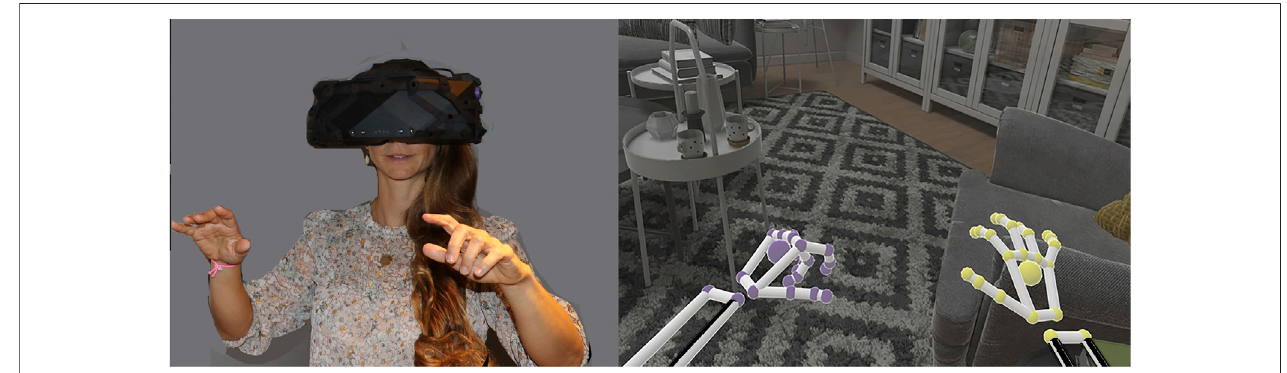
FIGURE2| Apersoninteractingwithvirtualobjectsinavirtuallivingroom,usingembodiedcyberhands,inarecentMaydayFundsupportedstudy(Hoffman,2021). Copyright Hunter Hoffman, www.vrpain.com, living room demo came with the high resolution, extra wide (180 degree) fi eld of view XTAL helmet by VRgineering.com.